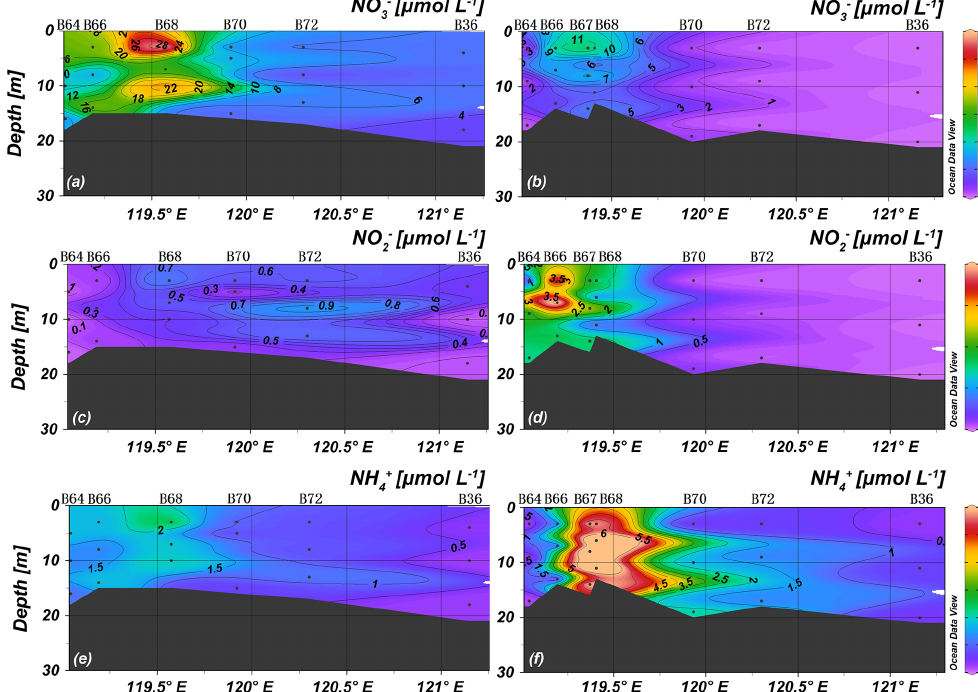
Figure 5. Nutrients of section 2 (µmolL − 1 ) for spring (a, c, e) and summer (b, d, f) .